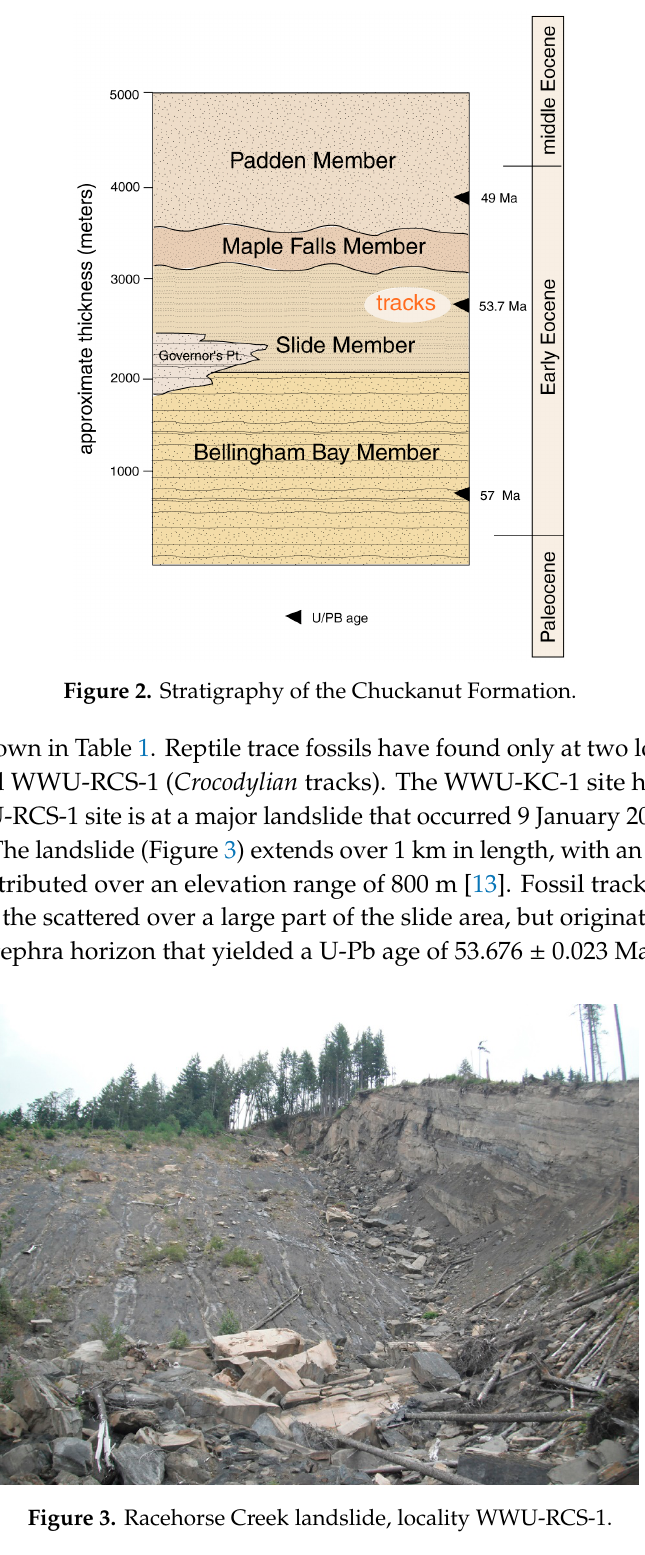
Figure 3. Racehorse Creek landslide, locality WWU-RCS-1.